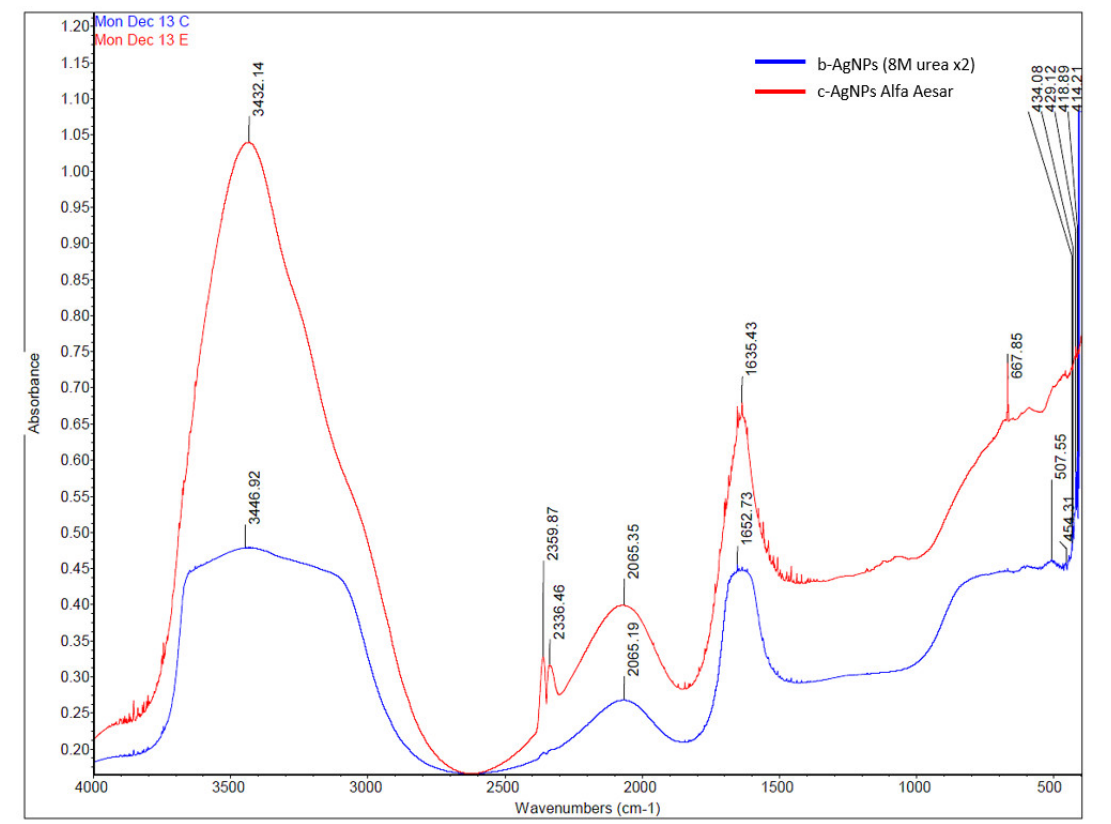
Figure 3. Fourier-transform infrared spectroscopy (FT-IR). Absorbance patterns of (C/blue) b-AgNPs